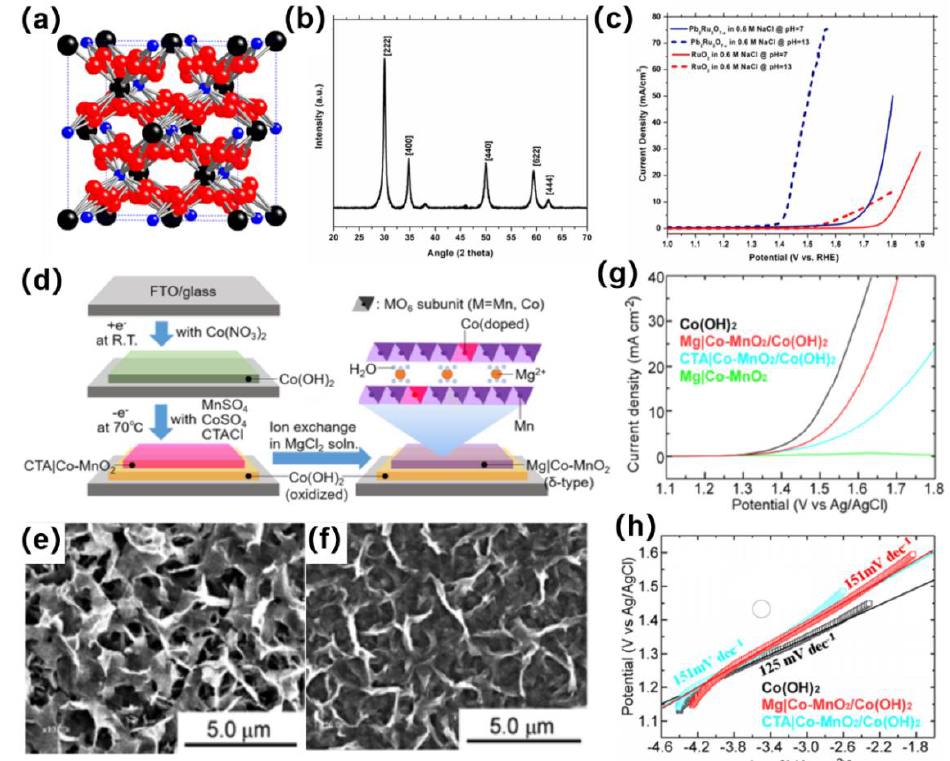
Figure 2. ( a ) Crystal structure of Pb 2 Ru 2 O 7 − x , ( b ) XRD of Pb 2 Ru 2 O 7 − x , and ( c ) LSV curves of Pb 2 Ru 2 O 7 − x and RuO 2 . Reproduced with permission from [58]. Copyright © 2020 American Chemical Society, ( d ) Schematic representation of Mg|CoMnO 2 /Co(OH) 2 bilayer structure, ( e , f ) SEM images of Co(OH) 2 and CTA|Co-MnO 2 /Co(OH) 2 , and ( g , h ) LSV curves and the corresponding Tafel plots for the relevant films. Reproduced with permission from [50]. Copyright © 2020, American Chemical Society.